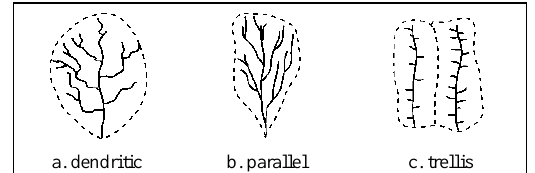
Drainage network patterns (diagrams modified from Ritter,